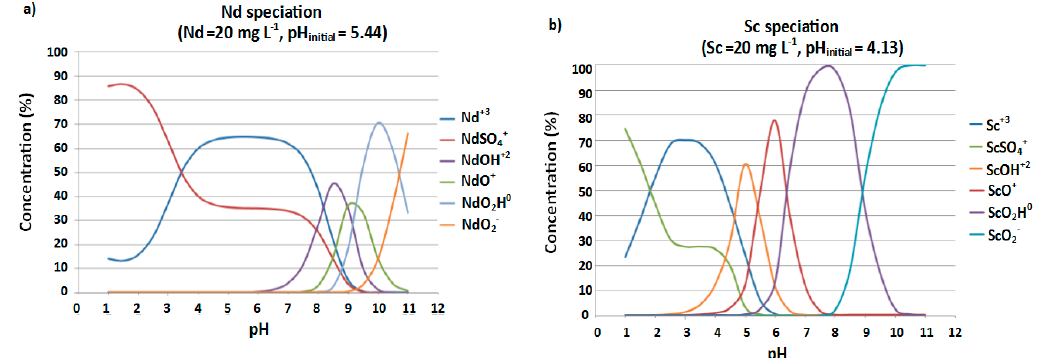
Figure 5. PHREEQC-3 calculated speciation diagrams of ( a ) Nd; and ( b ) Sc in aqueous solutions as a function of pH.